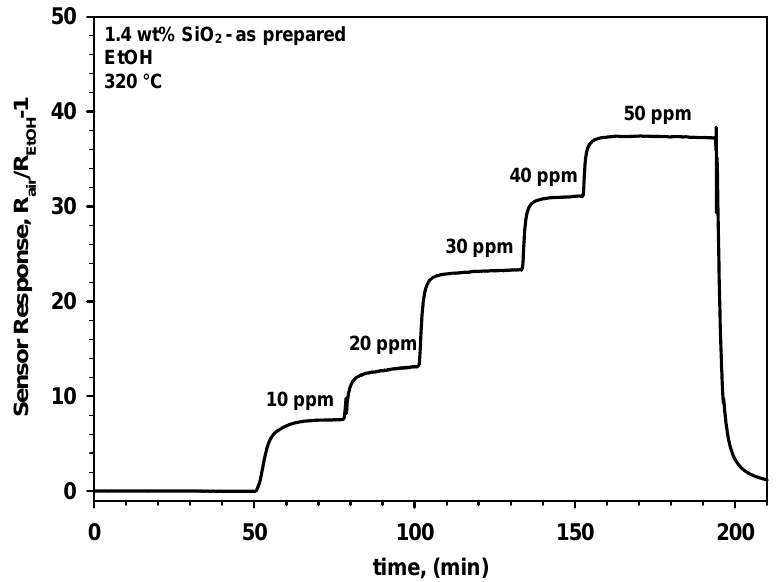
Figure 7. Response of a gas sensor made of as prepared 1.4 wt% SnO to increasing EtOH concentrations in dry